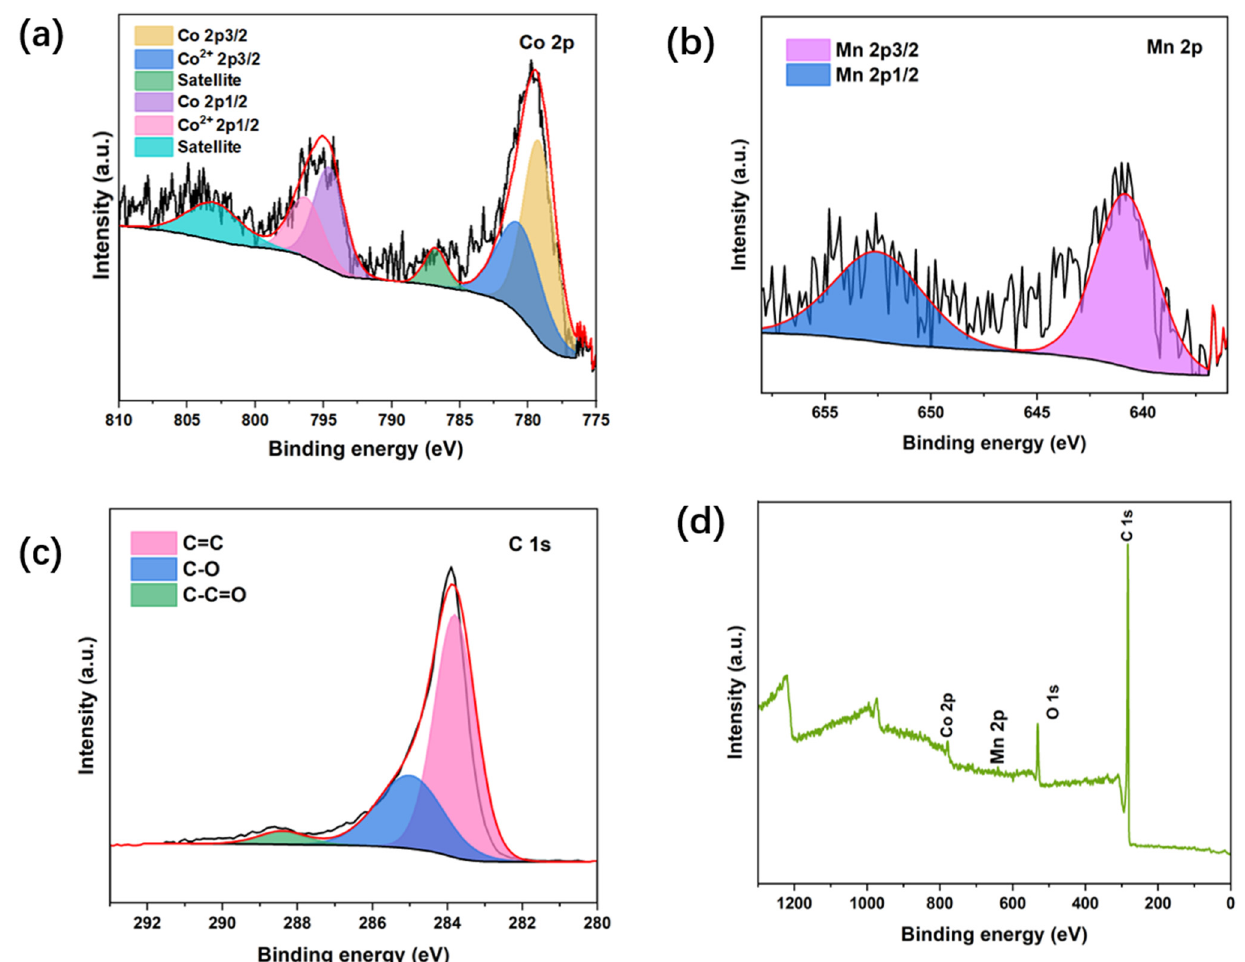
Figure 4. ( a – c ) high-resolution spectra Co 2p, Mn 2p, and C 1s, ( d ) Full scan XPS spectra of MnO- Co@C-0.3.